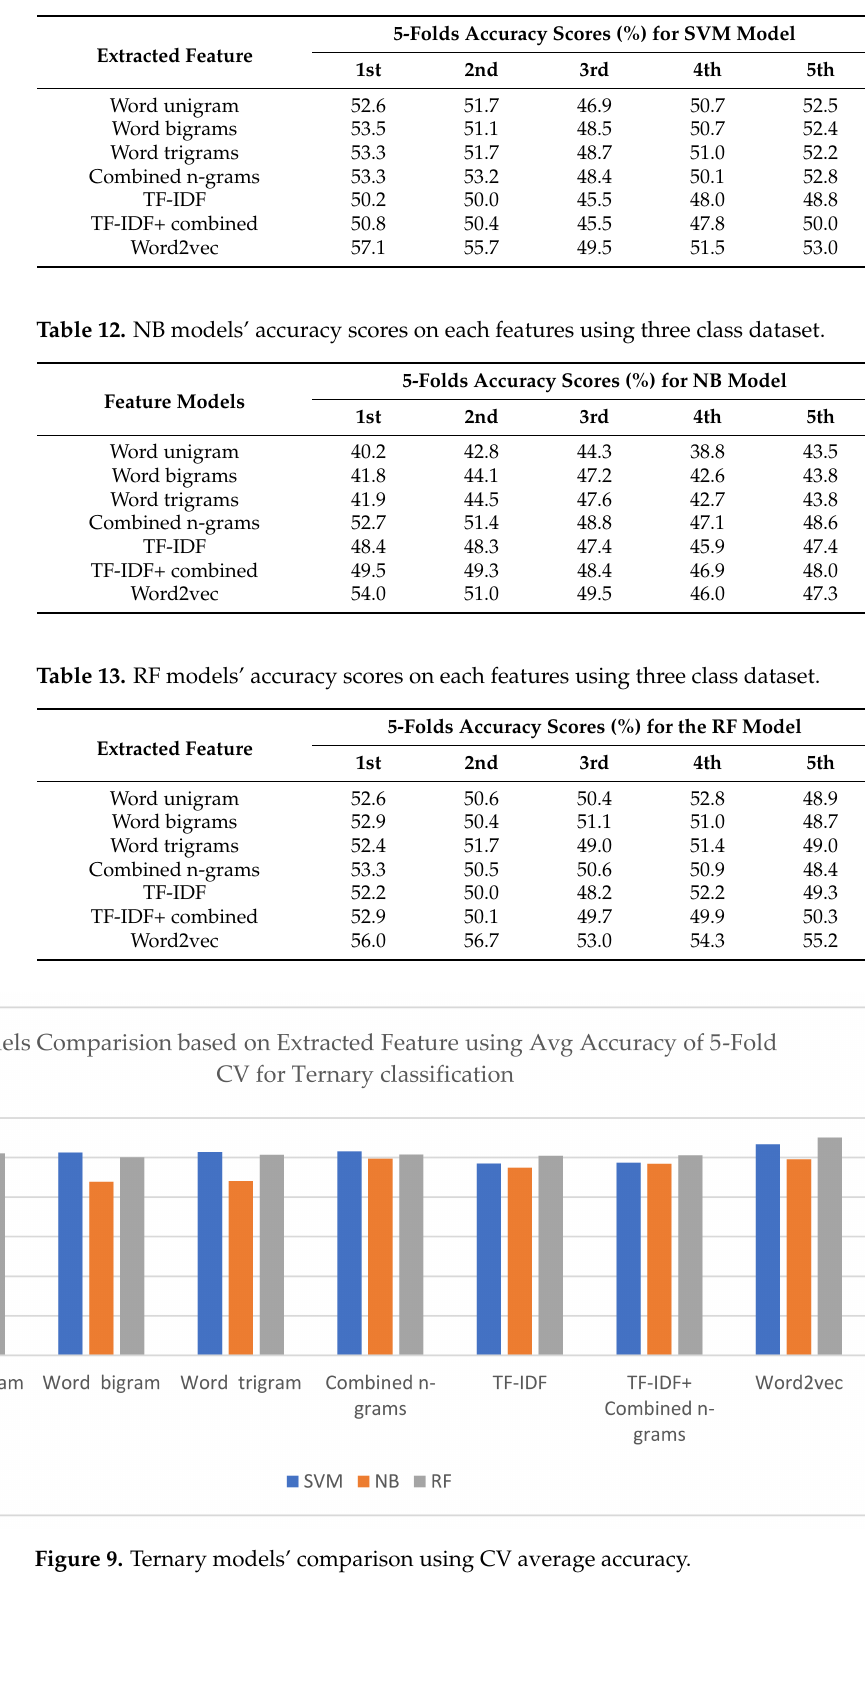
Table 11. SVM models’ accuracy scores on each features using three class dataset.